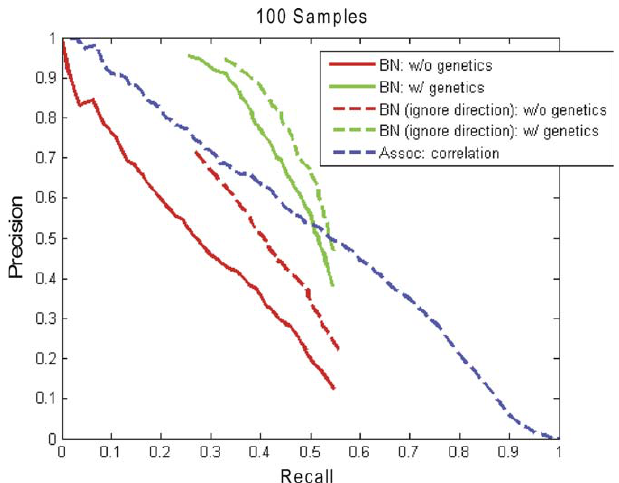
Figure 3. The Accuracy of Reconstruction of the Synthetic Network, Reconstructed with and without Genetic Information The genetics information not only helps to infer the direction of the relationships between nodes (solid lines), but also increases the power to detect relationships when direction is ignored, as with the association networks (dashed